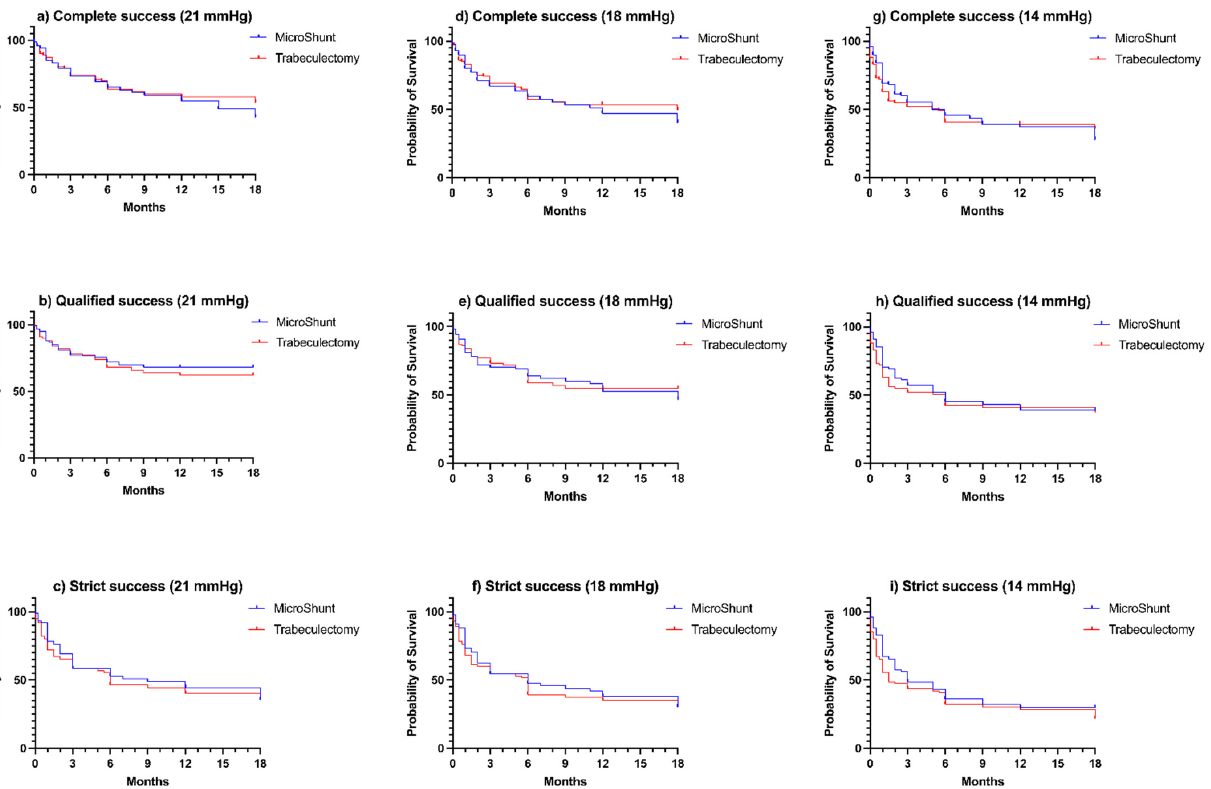
Figure 3. Kaplan–Meier survival curve of both groups during follow-up after MicroShunt and trabeculectomy: ( a ) complete success (IOP ≤ 21 mmHg; no theatre reoperation for glaucoma; no loss of light perception vision; no chronic hypotony (defined as IOP ≤ 5 mmHg on 2 consecutive follow-up visits from 3 months); and no use of postoperative adjunct medications to maintain adequate IOP), ( b ) qualified success (the aforementioned criteria, but with use of postoperative medications), ( c ) strict success (‘complete success’ criteria with at least 20% IOP reduction from baseline), ( d ) same as ‘( a )’ but with IOP ≤ 18 mmHg, ( e ) same as ‘( b )’ but with IOP ≤ 18 mmHg, ( f ) same as ‘( c )’ but with IOP ≤ 18 mmHg, ( g ) same as ‘( a )’ but with IOP ≤ 14 mmHg, ( h ) same as ‘( b )’ but with IOP ≤ 14 mmHg, and ( i ) same as ‘( c )’ but with IOP ≤ 14 mmHg. Log-rank (Mantel–Cox) test p -values were ( a ) p = 0.715, ( b ) p = 0.595, ( c ) p = 0.489, ( d ) p = 0.645, ( e ) p = 0.828, ( f ) p = 0.494, ( g ) p = 0.616, ( h ) p = 0.464, and ( i ) p =